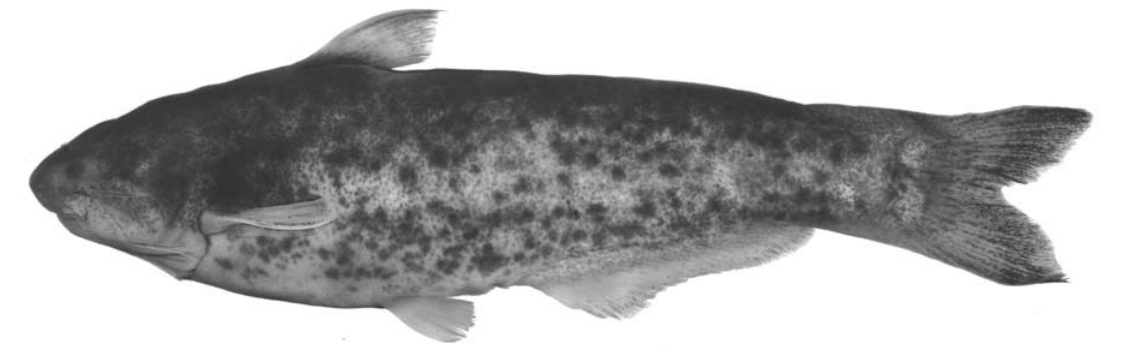
fig. a [type locality: río Torbes, 1 km. above Táriba, Orinoco